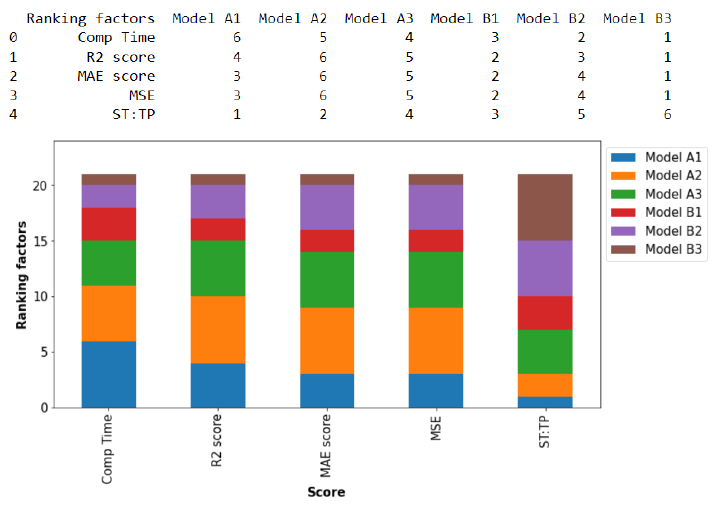
Figure 8. Ranking of models for